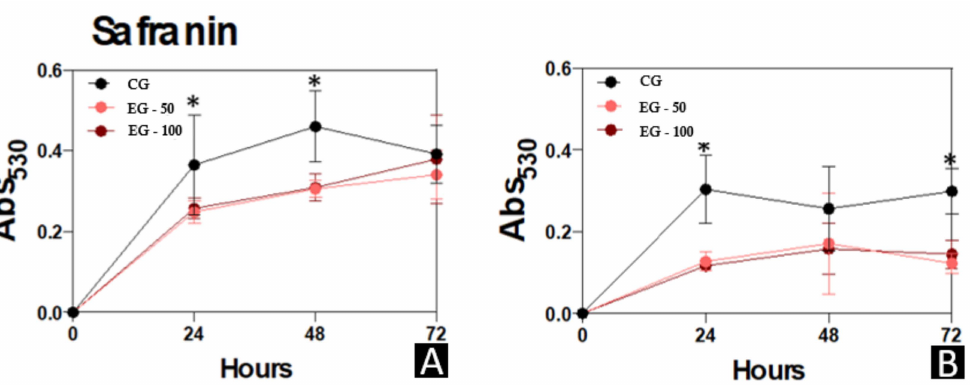
Figure 7. Extracellular matrix in biofilm formed by C. albicans and S. mutans for 24, 48, and 72 h at 37 ◦ C. ( A ), C. albicans . ( B ), S. mutans. mutans . At each time point evaluated, the systems were processed to detect extracellular matrix by staining with safranin at 530 nm. Results are expressed as the mean ± standard deviation of three independent replicates. * p <